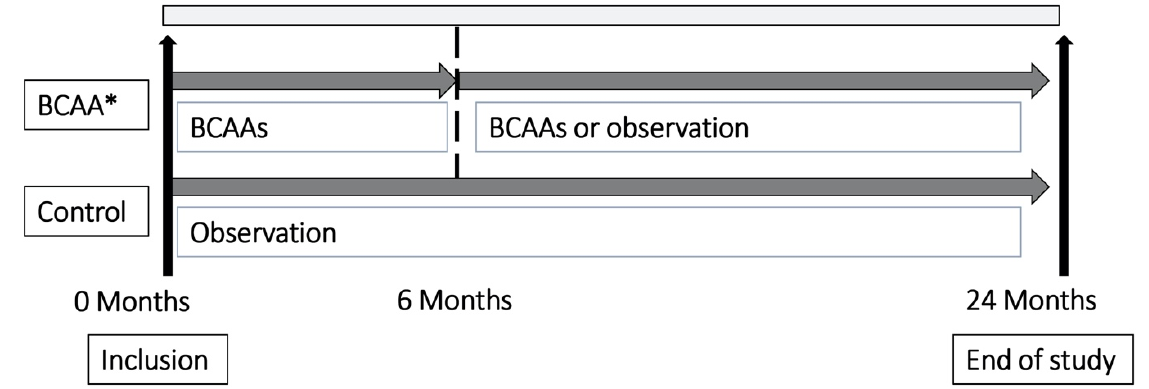
Figure 1. Scheme of the study. * Adherence of patients to prescribed BCAAs was > 80%. BCAA, branched ‐ chain amino acid.